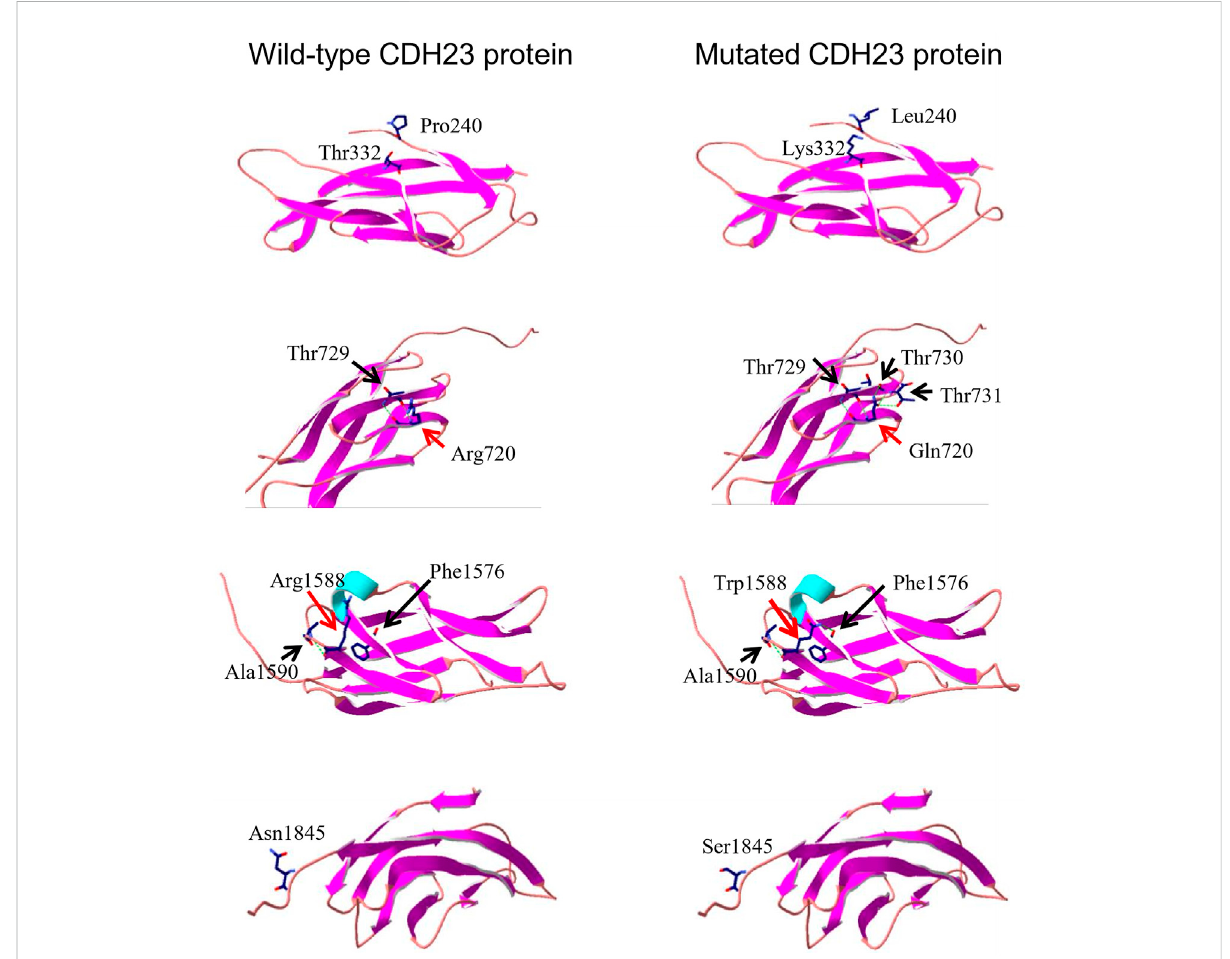
FIGURE 3 Three-dimensional protein structure analysis of fi ve mutation-containing regions in CDH23. Four wild-type EC repeats (EC3, EC7, EC15, and EC17) CDH23 protein structures are listed on the left panels; four mutated counter parts are on the right. The locations of amino acid 240, 332, and 1845 do not have hydrogen bond formed with the surrounding amino acids. On the other hand, the residue R720 or R1588 may form several hydrogen bonds with surrounding amino acids (indicated by a dotted green